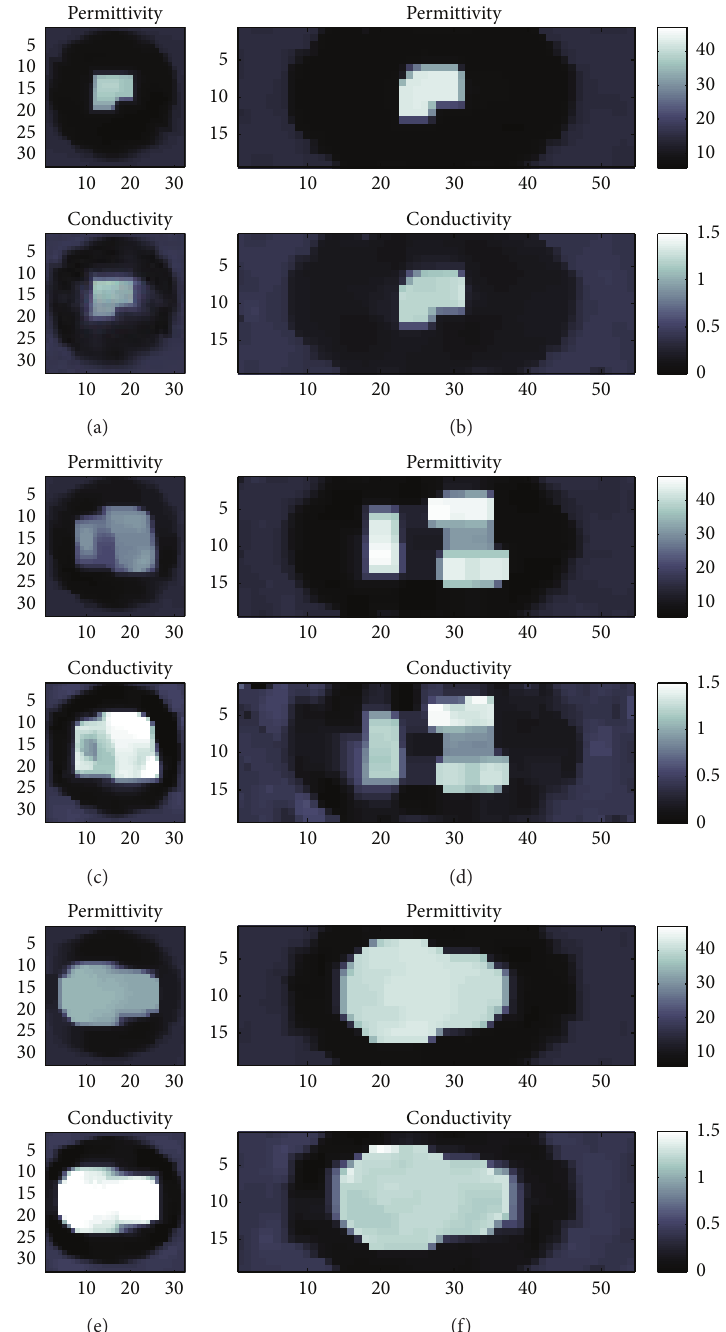
Figure 7: Reconstructions for the different phantoms for an SNR of 40dB. (a) (b) Mostly fatty phantoms. (c) and (d) Scattered fibroglandular phantoms. (e) and (f) Very dense phantoms. Left Side: no compression. Right side: with